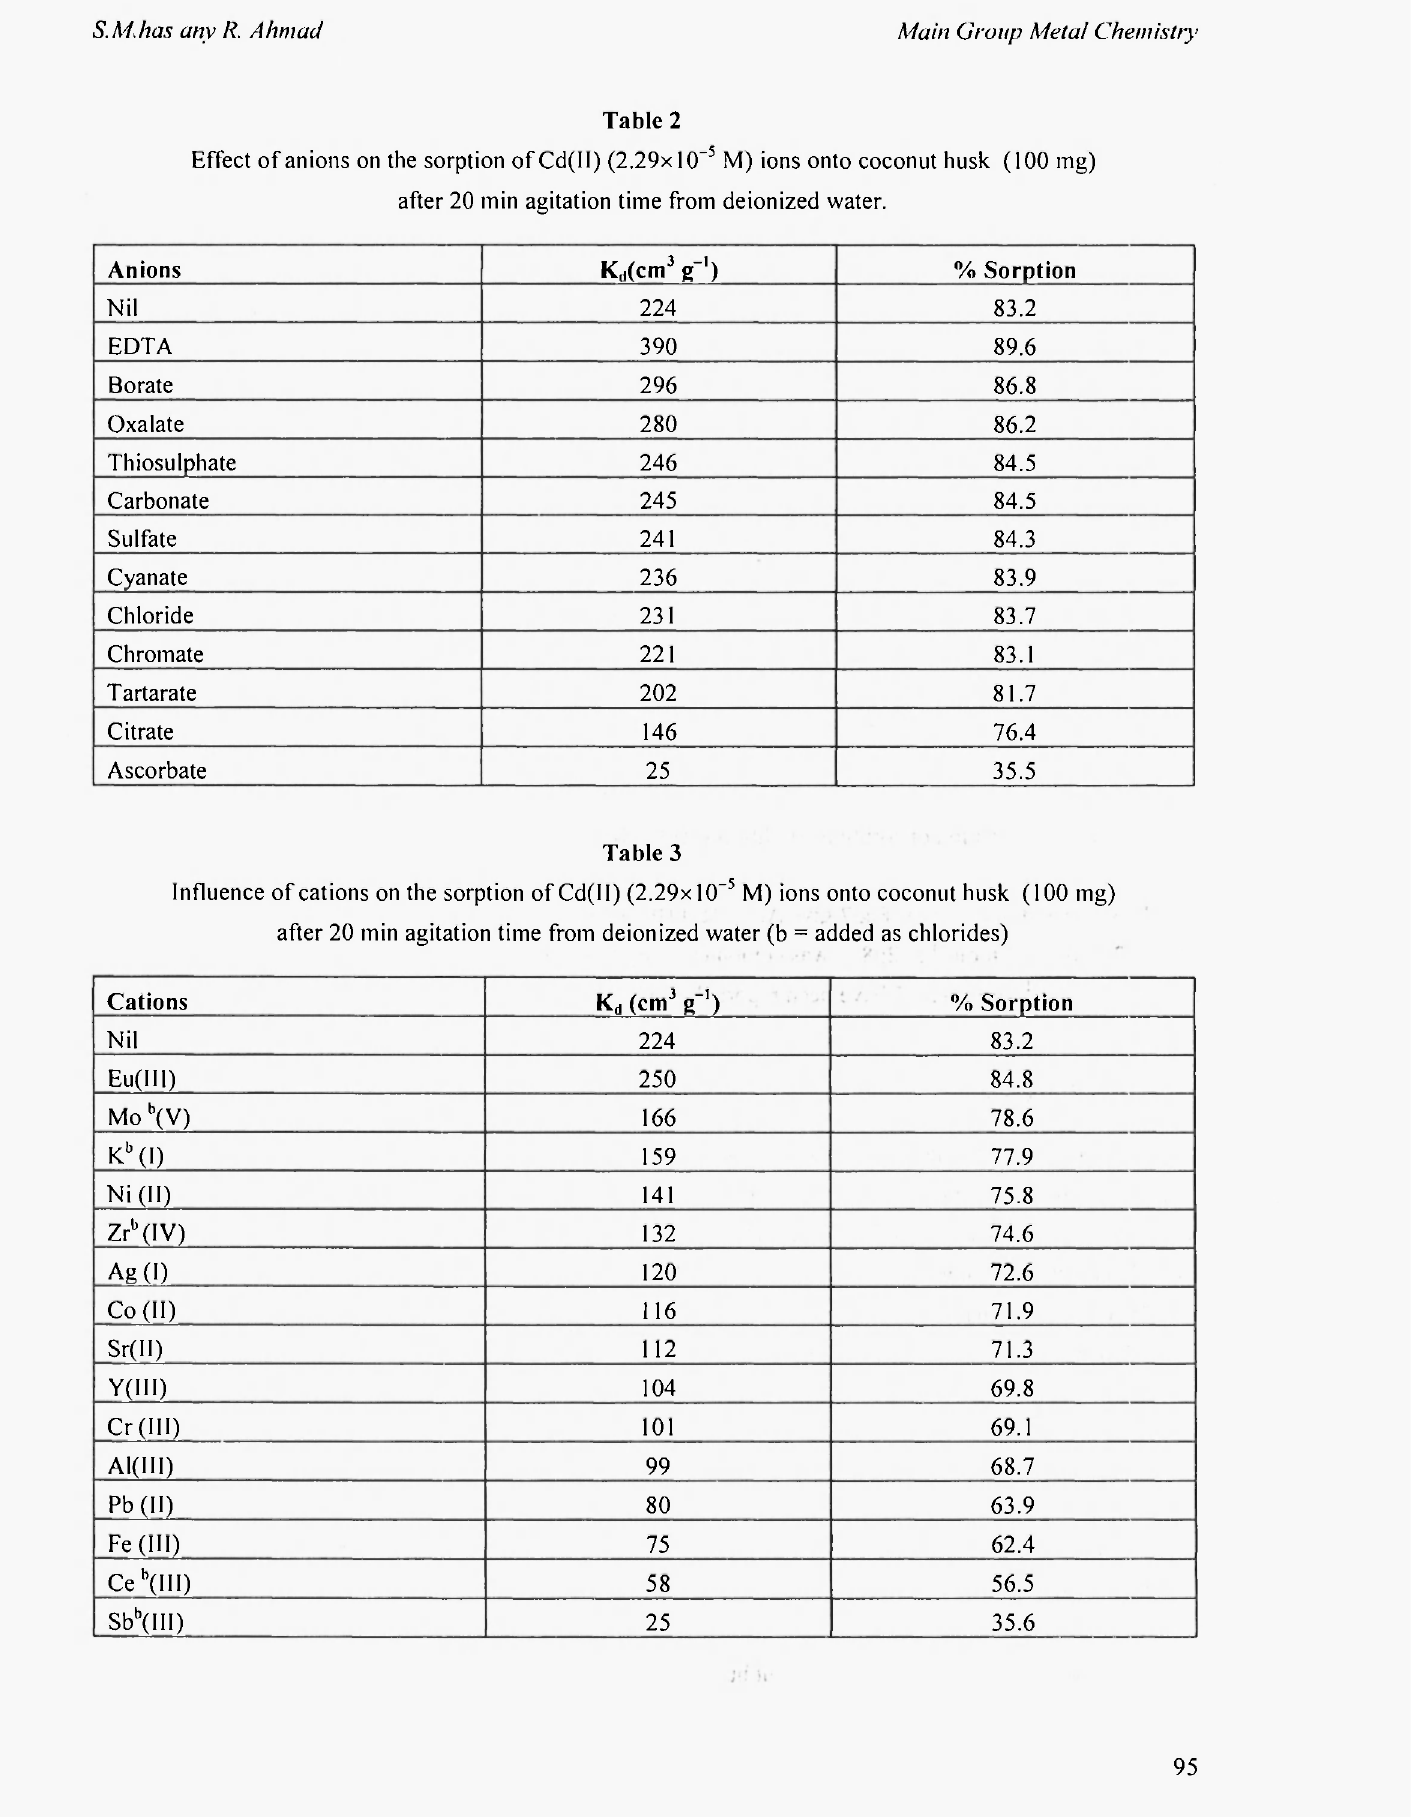
Effect of anions on the sorption ofCd(II) (2.29χ1(Γ 5 Μ) ions onto coconut husk (100 mg) after 20 min agitation time from deionized